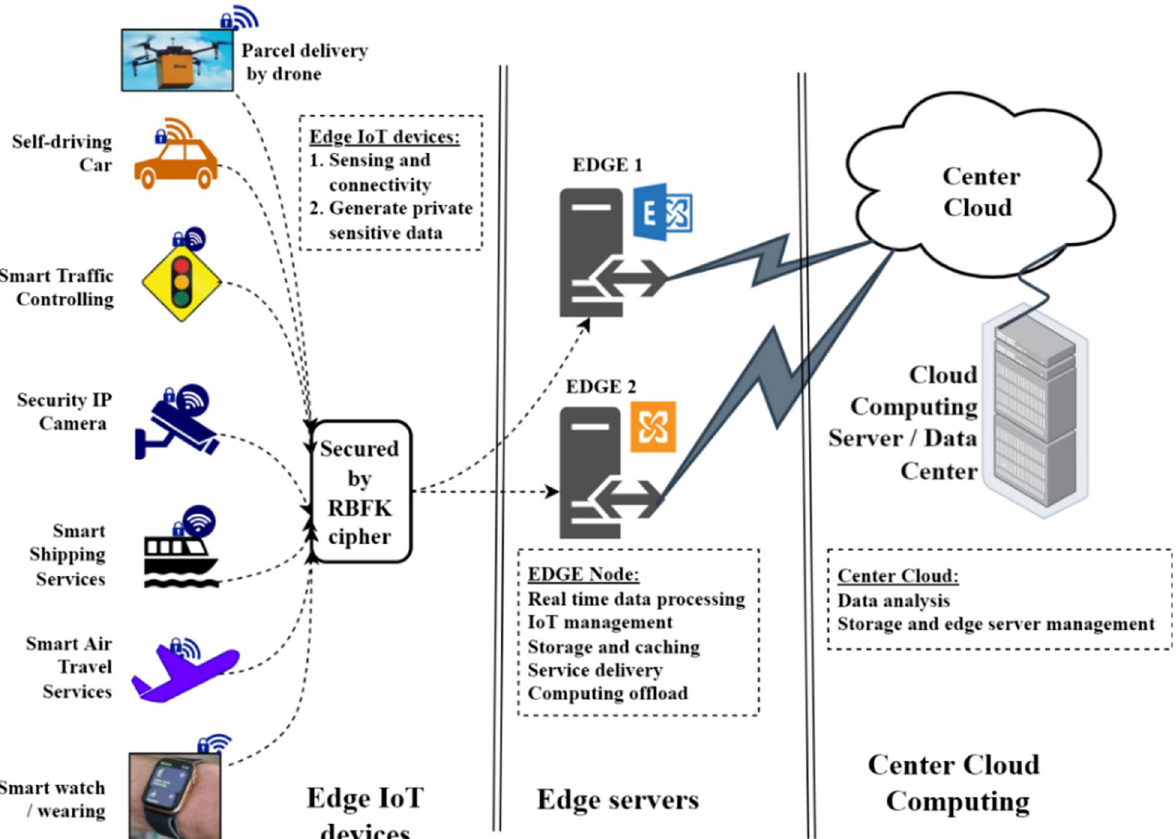
Fig. 1 Application of RBFK cipher for IoT devices in the edge